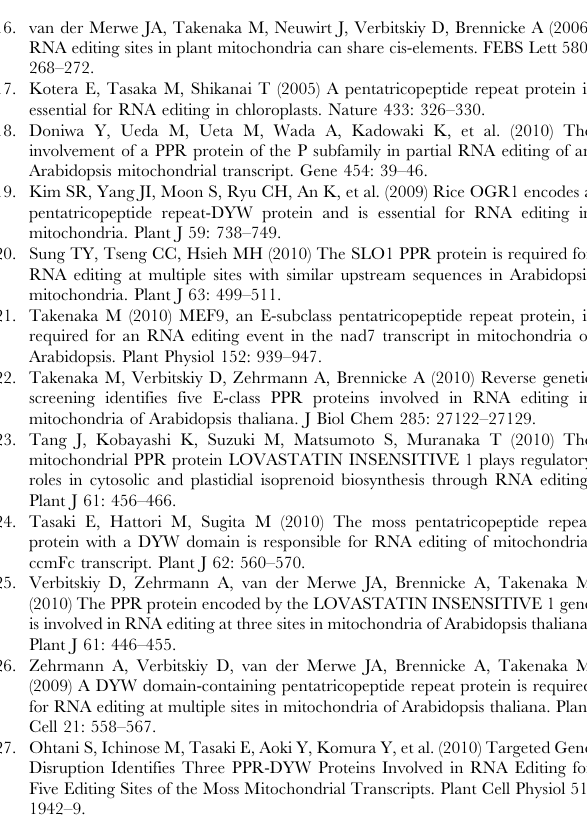
Figure S1 Editing profile of cox2 transcripts single mutants. Mutations were performed on the 2 1 or + 1 nearest neighbor residue of the editing target. The number of the editing site corresponds to the position of the C target in the mature